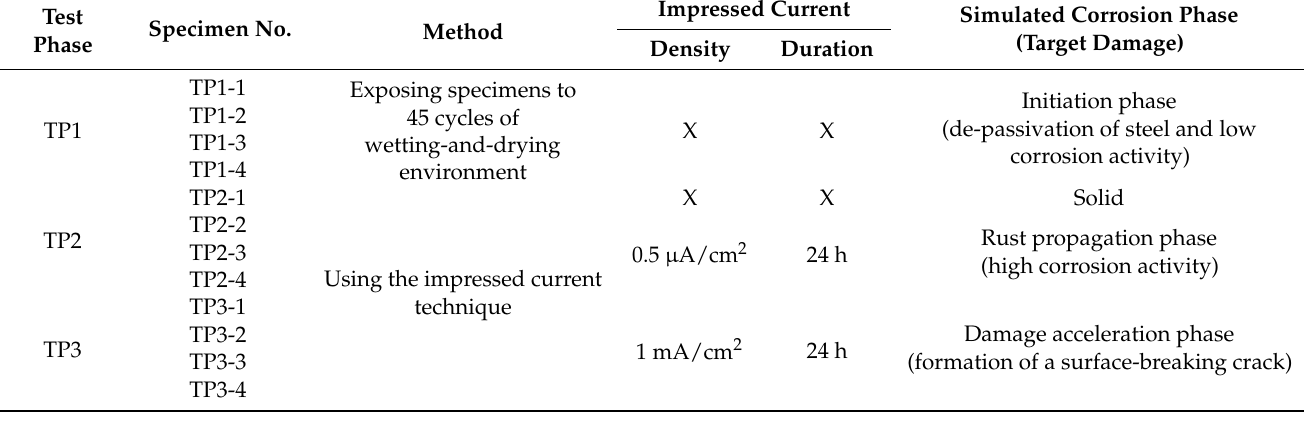
Table 1. Summary of accelerated corrosion test methods to prepare damaged concrete samples with three different target corrosion levels (corrosion initiation, rust propagation, and damage acceleration phases) for the experimental phases 1, 2 and 3, respectively.